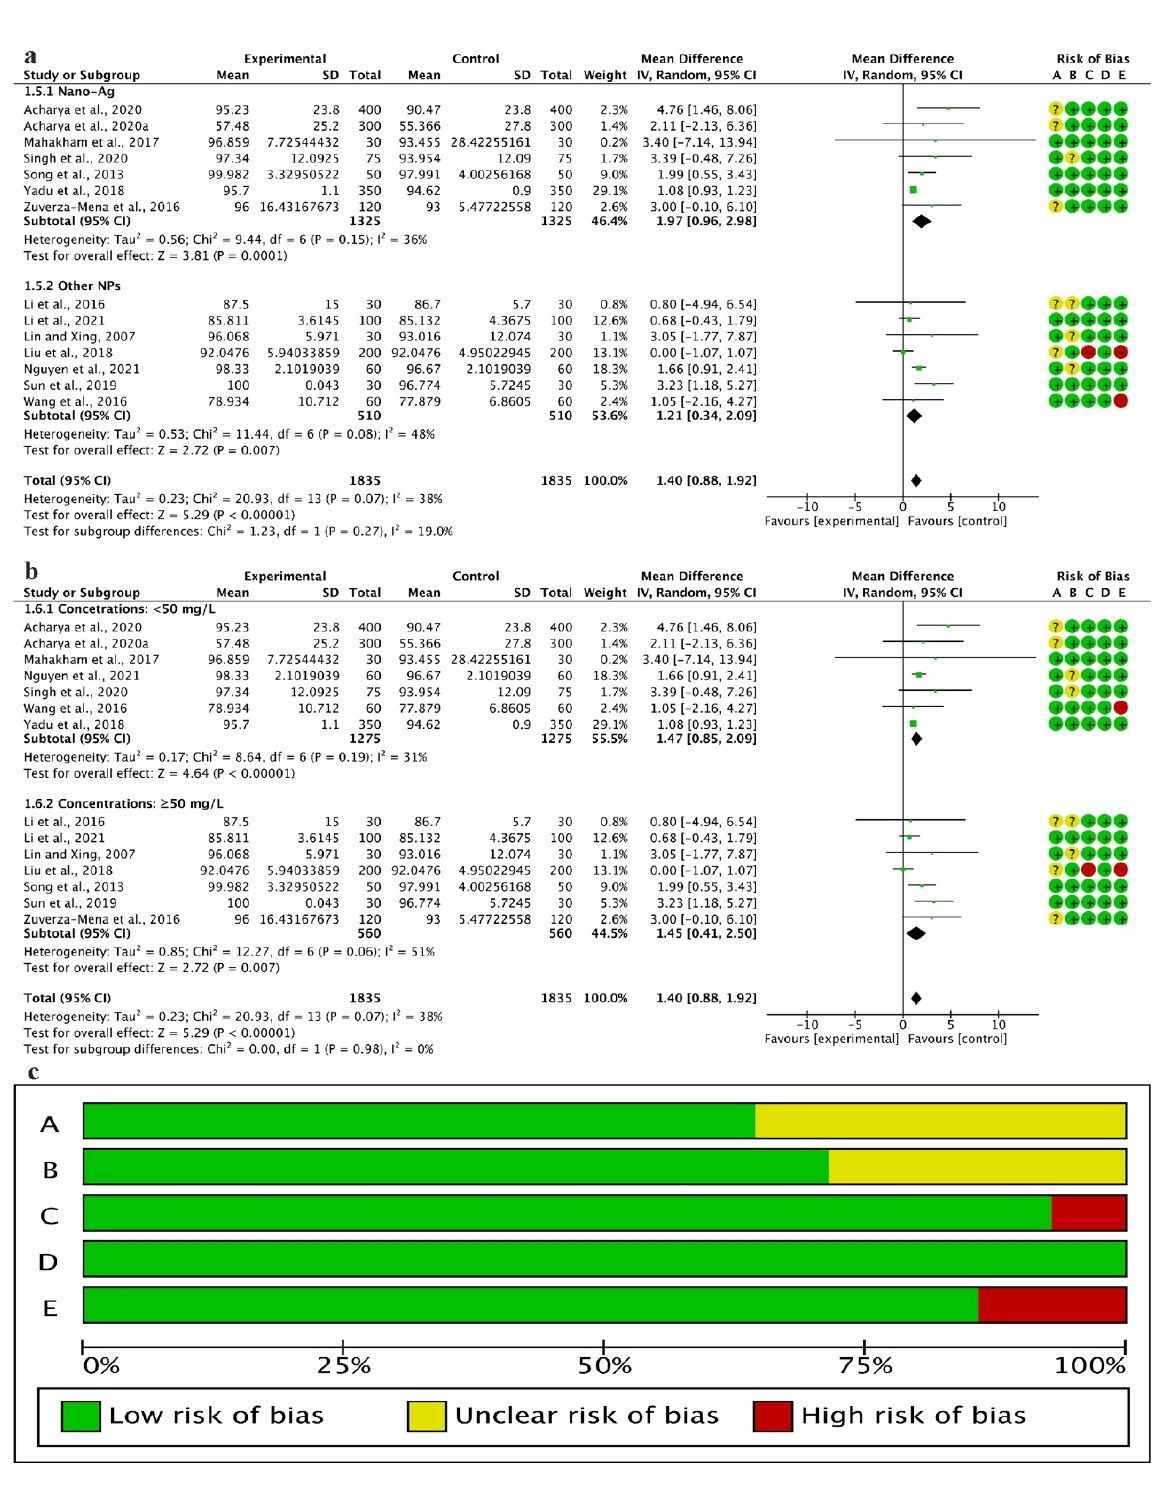
Figure 4. Heterogeneity evaluation, subgroup analysis, and risk of bias assessment for FGP. ( a ) Sub- group analysis for NP types; ( b ) subgroup analysis for NP concentrations; ( c ) risk of bias assessment, A—sterilizing the seeds used in all treatments, B—seed germination and seedling growth under controlled conditions, C—seed exposure to a direct nanoparticle suspension, D—uniformity of the seeds, E—cultivation of the seeds on the filter papers inside Petri dishes (the same below).